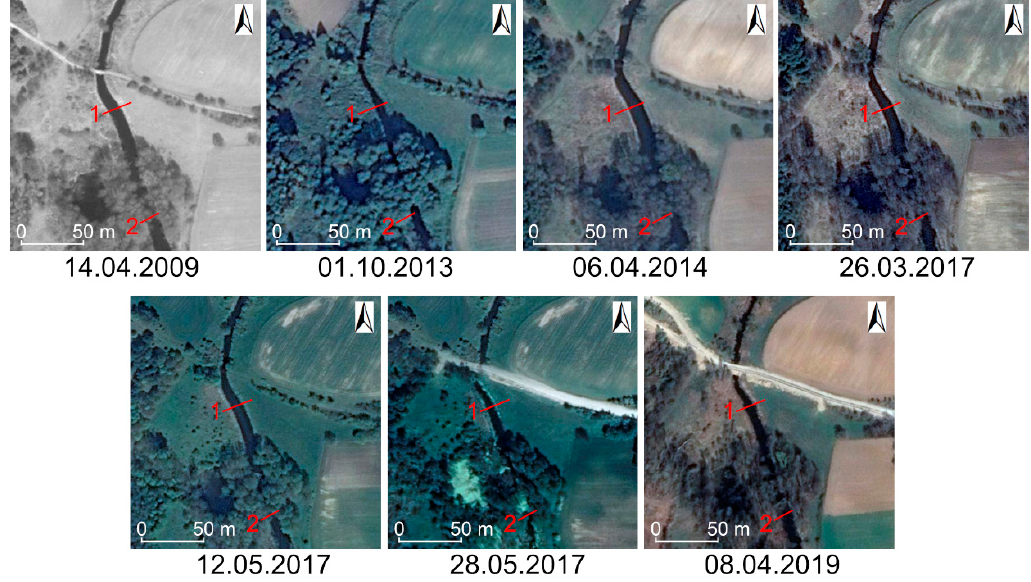
Figure 2. Changes of land cover and shading of the watercourse in different periods and years (images obtained from GoogleEarthPro).